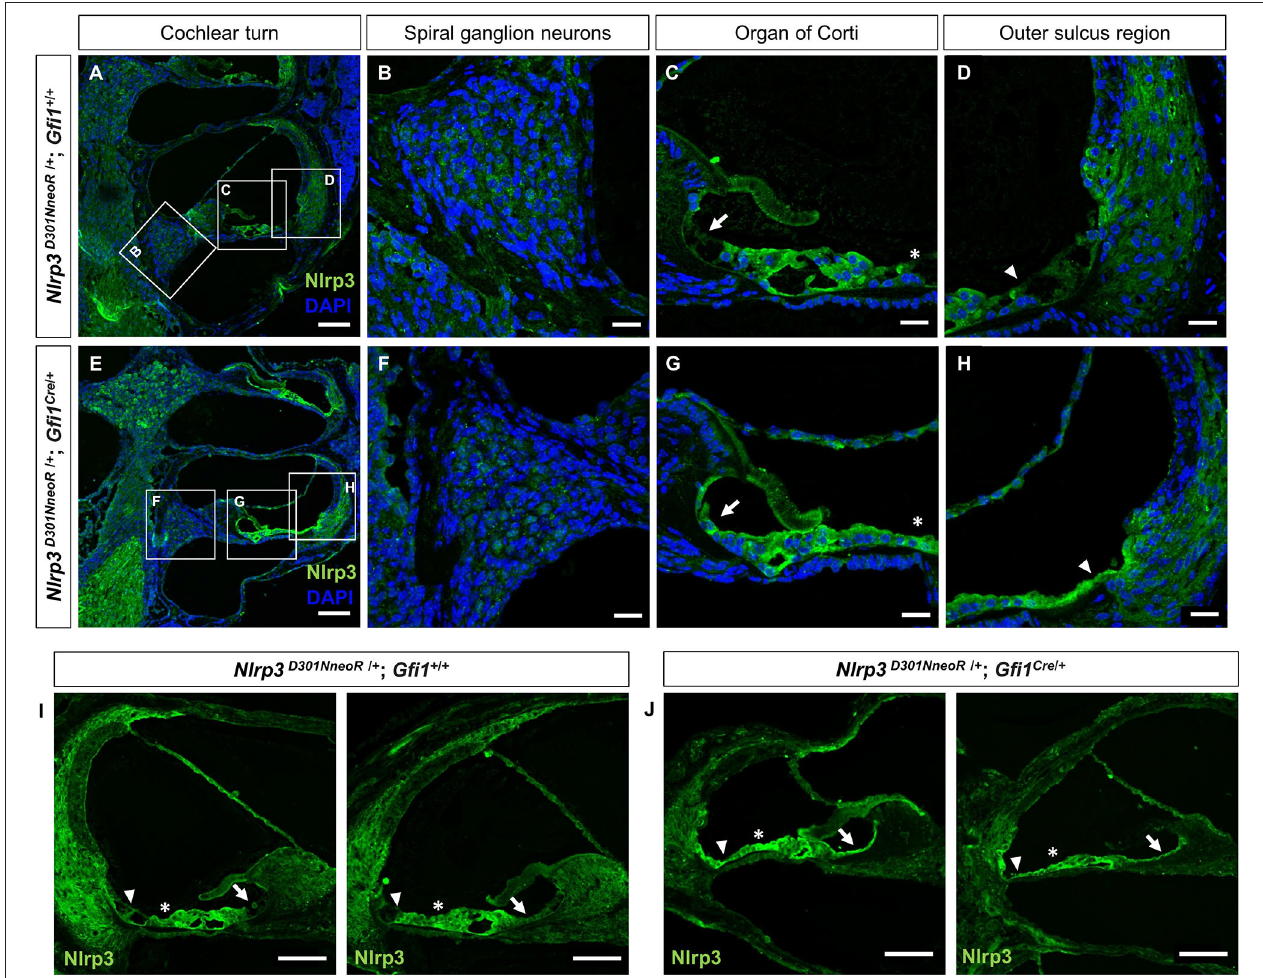
FIGURE 3 | Inner ear section immunohistochemistry from P15 Nlrp3 D 301 NneoR / + ; Gfi1 Cre / + and Nlrp3 D 301 NneoR / + ; Gfi1 + / + mice stained with an anti-NLRP3 antibody. Nlrp3 was more widely overexpressed in the Nlrp3 D 301 NneoR / + ; Gfi1 Cre / + mouse (E–H) than in the Nlrp3 D 301 NneoR / + ; Gfi1 + / + mouse (A–D) . In both